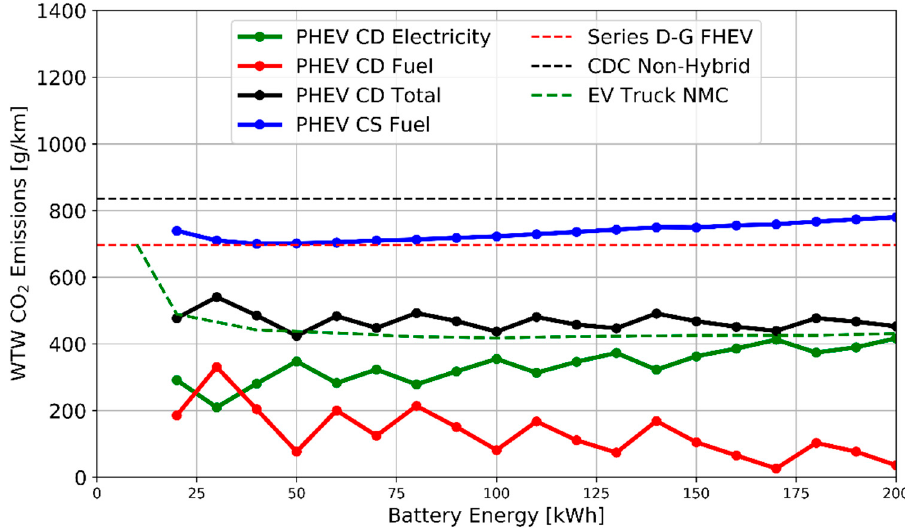
Figure 12. Plug-in hybrid well-to-wheel CO 2 emissions divided in energy sources (electricity, fuel, and total) and mode (CD and CS) under a WHVC with 50% payload. Nonhybrid, full hybrid, and pure electric are added for comparison.